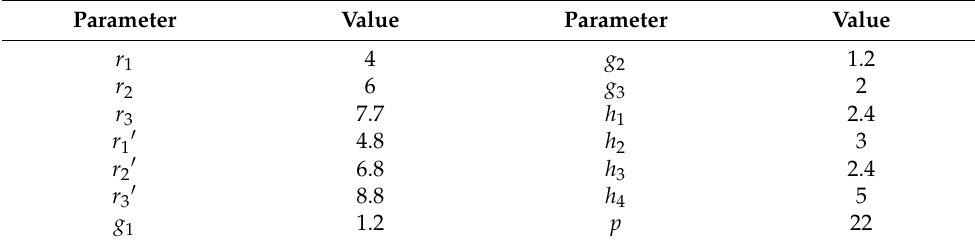
Table 1. Structural Parameters of Converter. (Unit: mm).